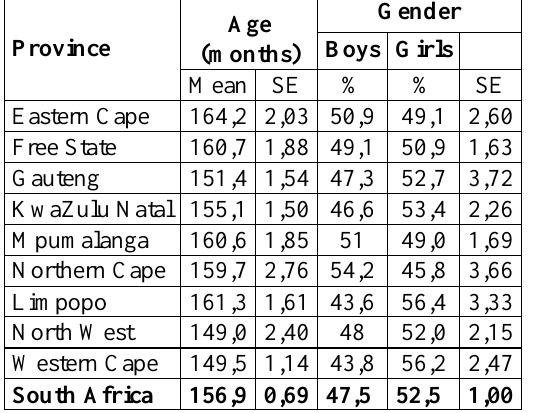
Table 1. Personal characteristics: age and gender The data concerning the age of learners